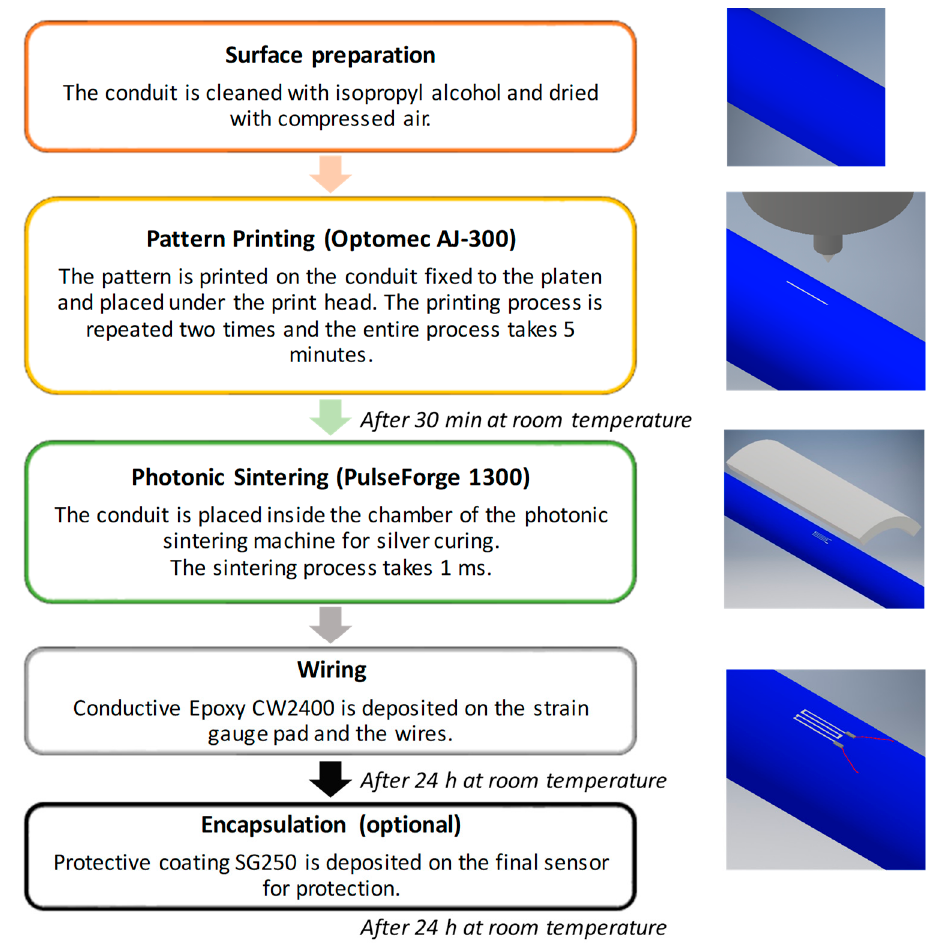
Figure 2. Manufacturing process for a strain gauge printed directly on a conduit. All the phases are performed at room temperature.